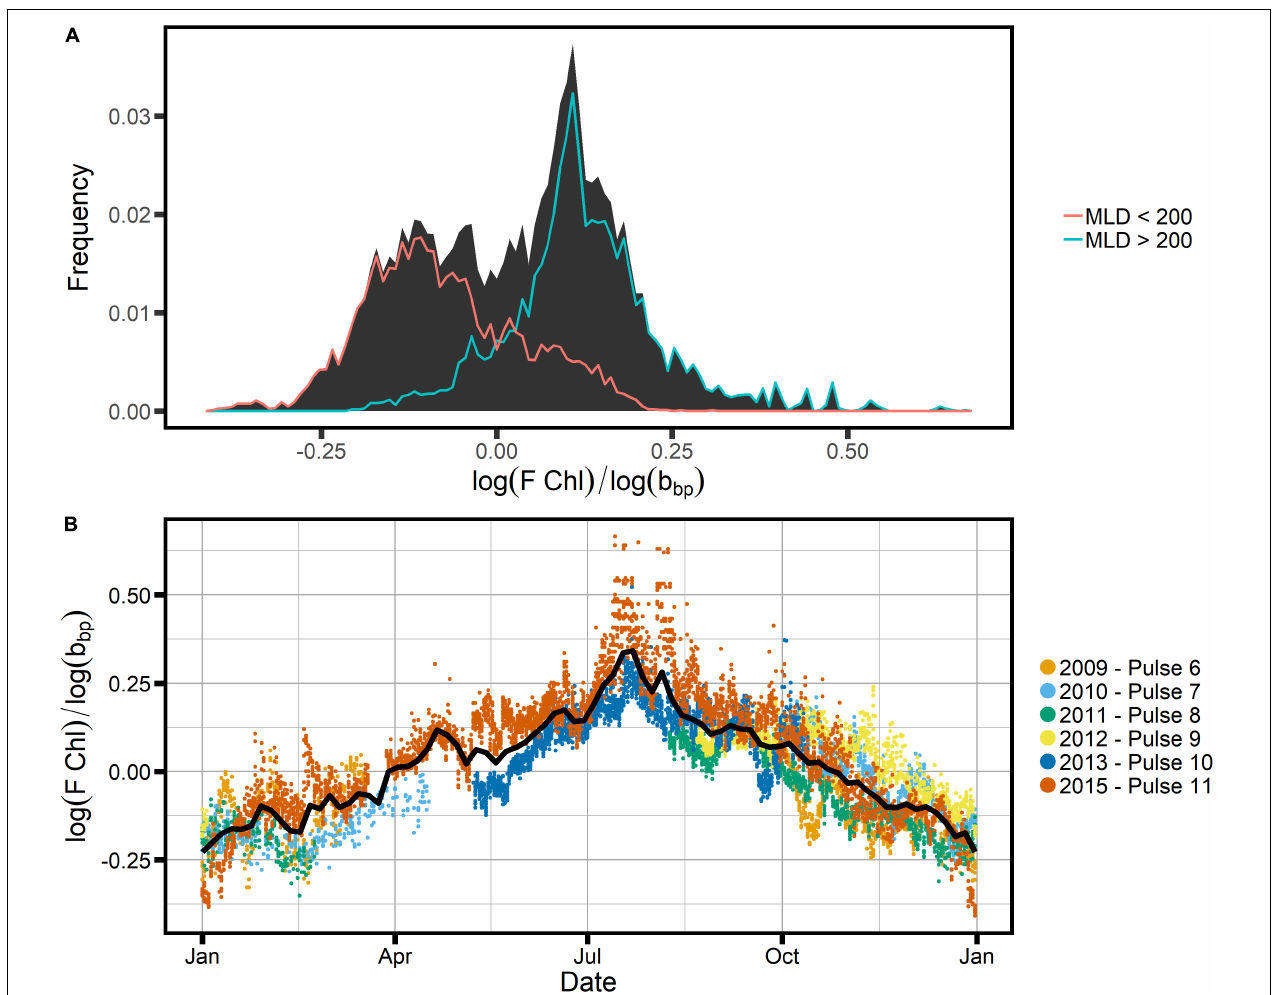
FIGURE 10 | (A) The frequency distribution of the ratio log(FChl):log(b bp ), overlain with the frequency distributions of sample populations split based on the indicated MLD criteria, using the GAM-smoothed MLD in Figure 8C as a guide. (B) The annual cycle of the same ratio, with colors indicating different mooring deployments